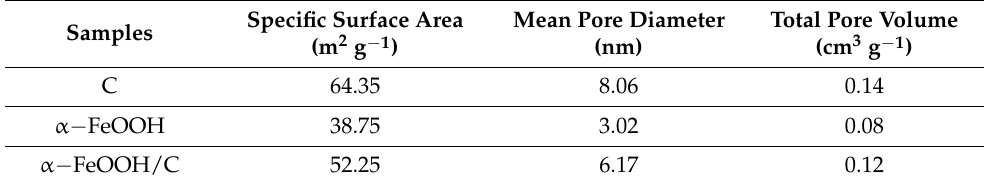
Table 1. BET specific surface areas, mean pore diameters and total pore volumes of α -FeOOH, C and the α -FeOOH/C composite.